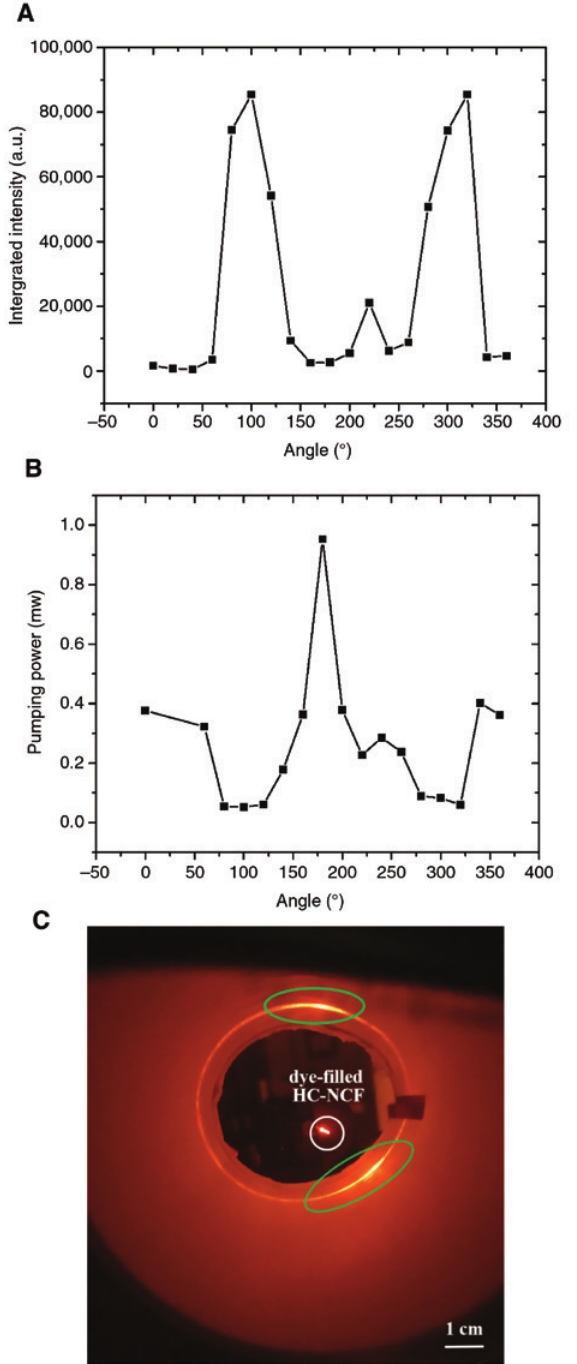
Figure 7: Relations between output intensity, pumping power and different output directions, and output pattern. Relationship (A) between the laser emission intensity and output direction, and (B) between the pumping power and output direction. (C) Filtered output emission irradiating on a columnar screen sur- rounding the